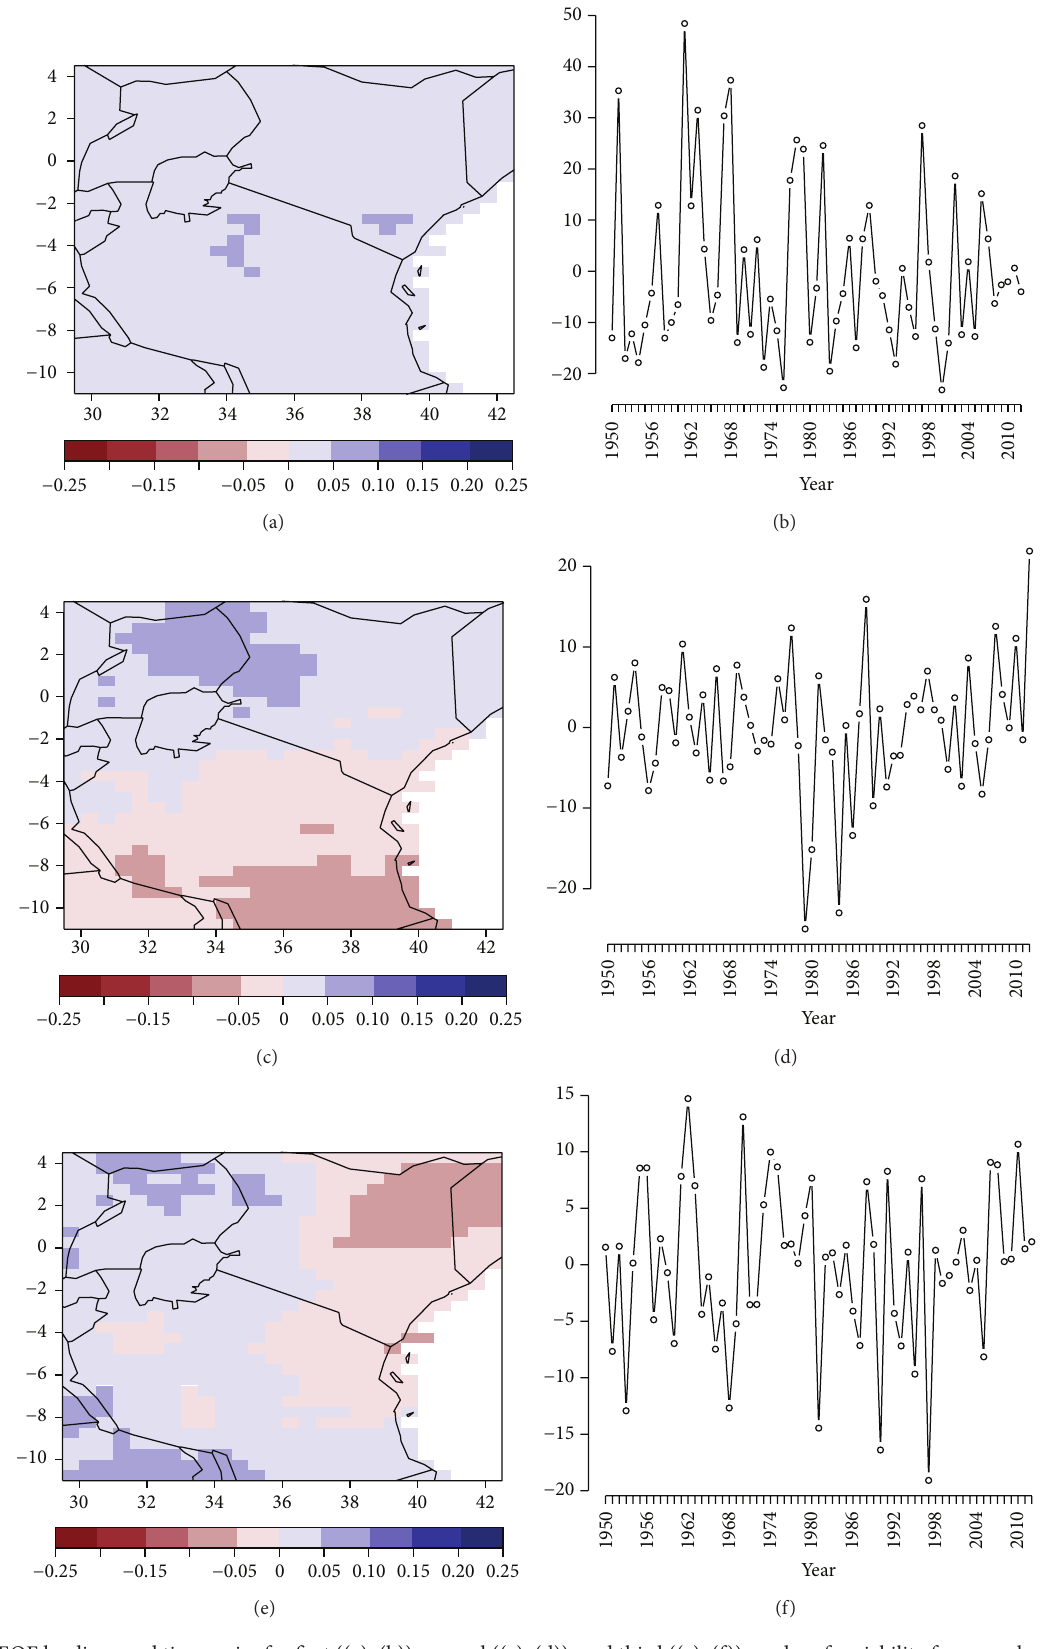
Figure 3: EOF loadings and time series for first ((a), (b)), second ((c), (d)), and third ((e), (f)) modes of variability for annual